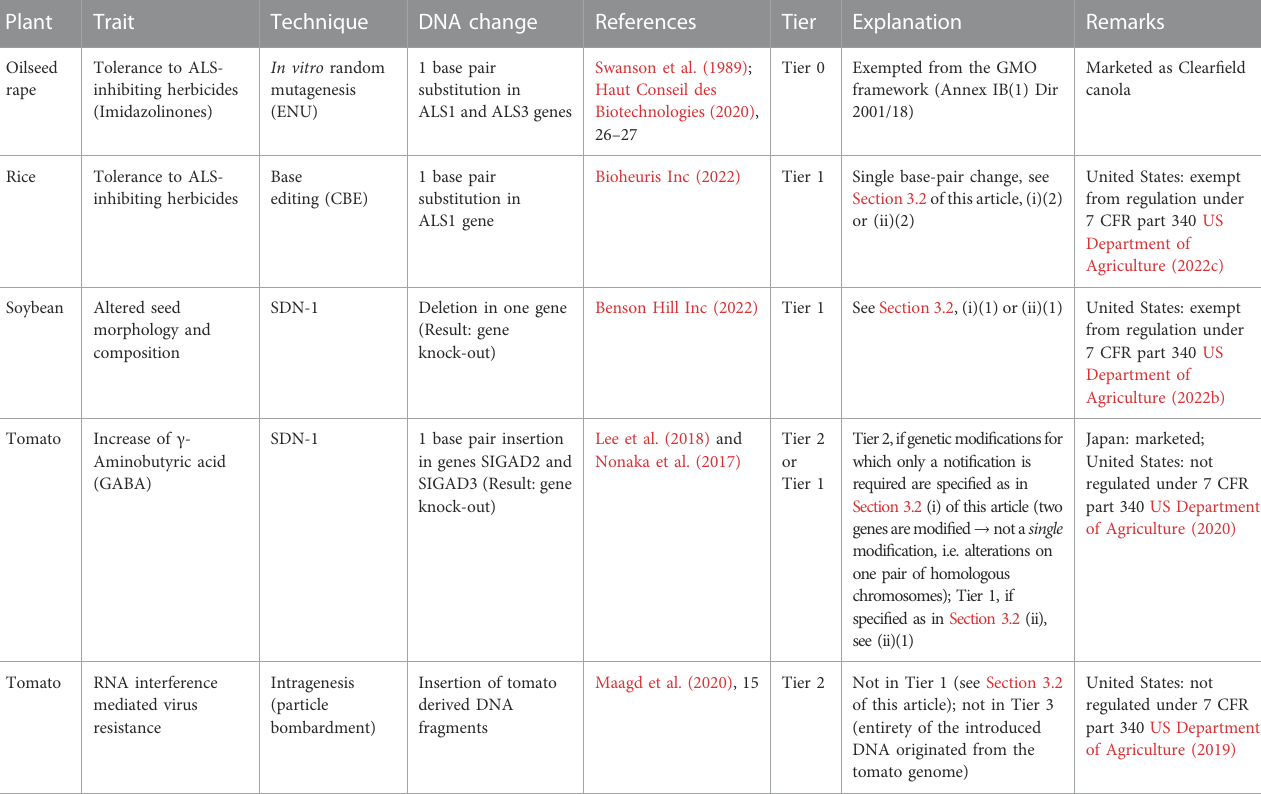
TABLE 2 Examples illustrating the applicable tier. Plant